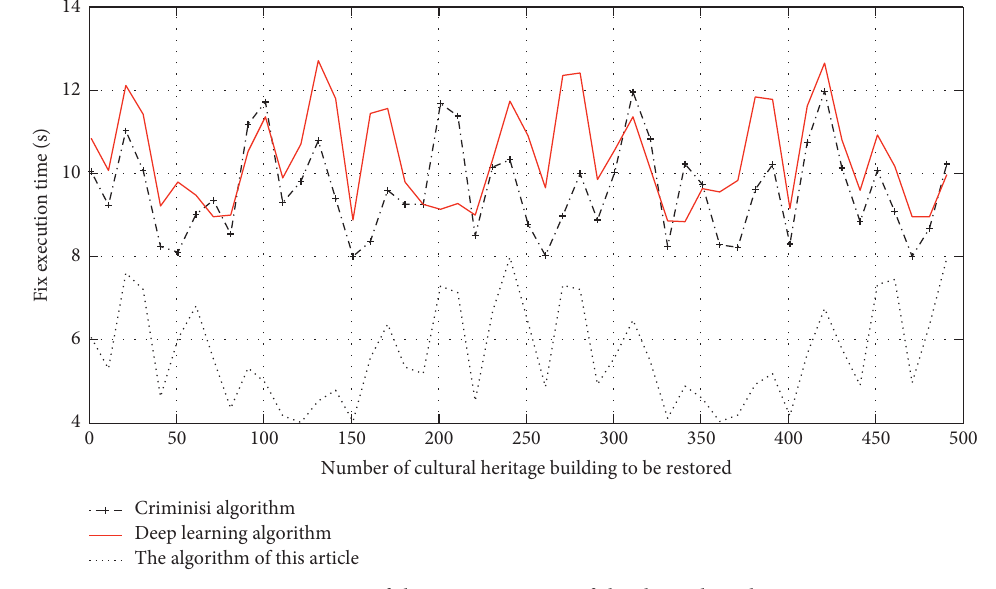
Figure 6: Comparison of the execution time of the three algorithm